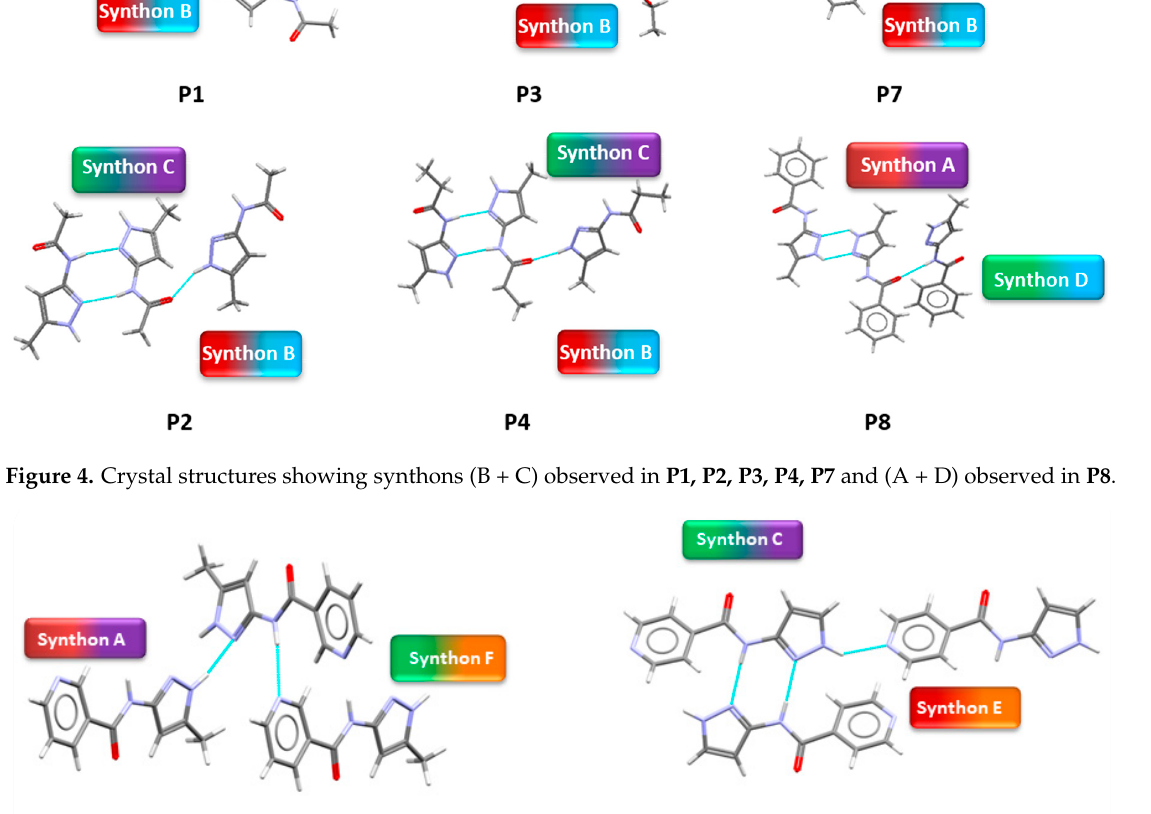
Figure 5. Crystal structures showing synthon (A + F) observed in P10 and (C + E) in P11 .